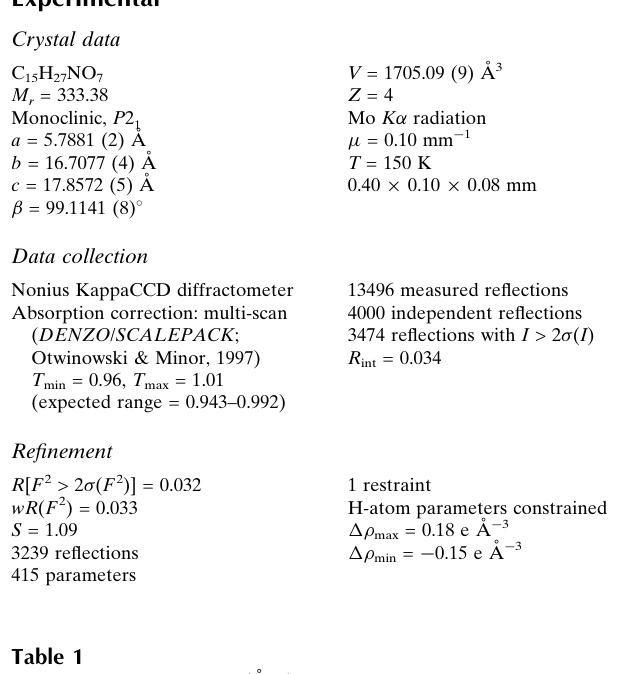
Hydrogen-bond geometry (A˚ , (cid:1)